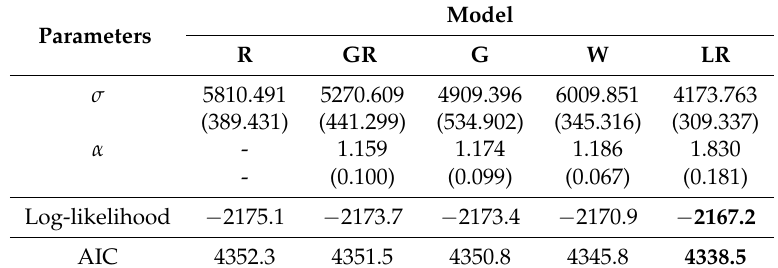
Table 7. Parameter estimates (standard errors) and maximum values of the log-likelihood functions of the E, GE, G, W and LE models fitted to the monoclonal gammopathy data.